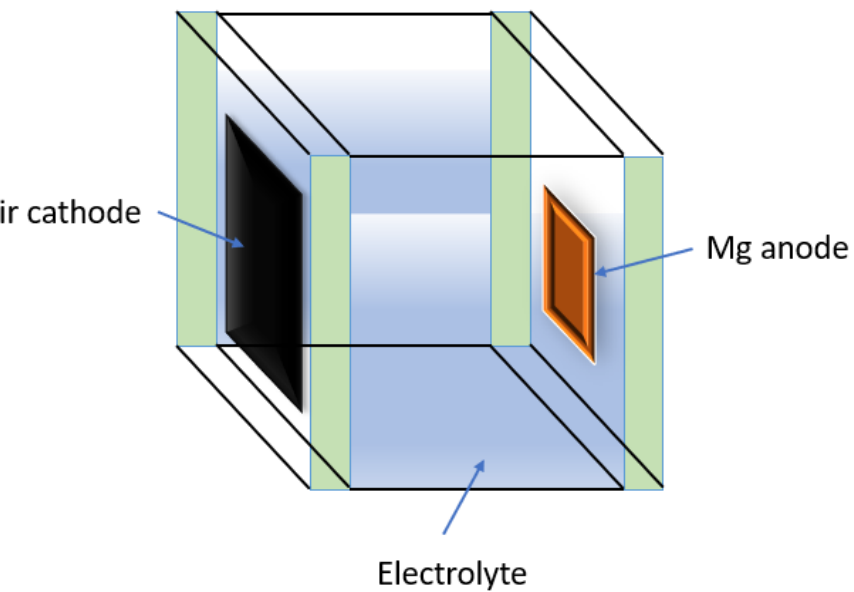
Figure 20. Schematic diagram of the structure of a Mg-air battery.